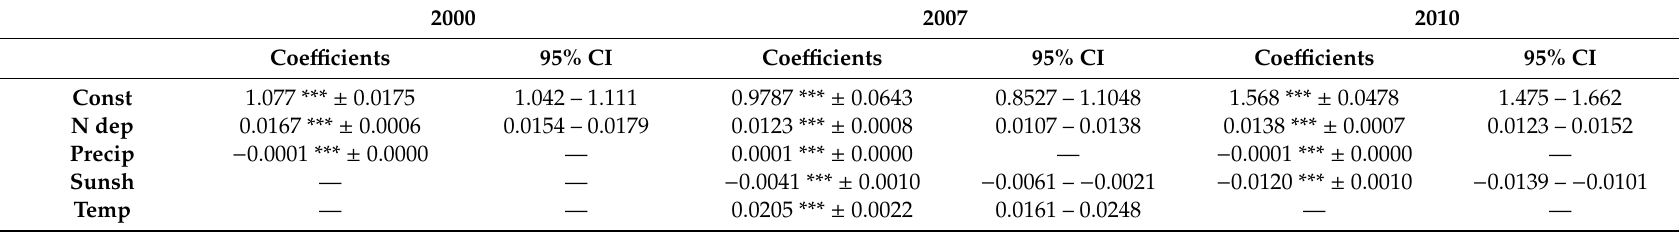
Table 9. Regression coe ffi cients with heteroscedasticity-consistent standard errors for croplands / natural vegetation mosaic. Const: Constant, N dep: N deposition, Temp: Temperature, Precip: Precipitation, and Sunsh: Sunshine. *** Statistically significant p <